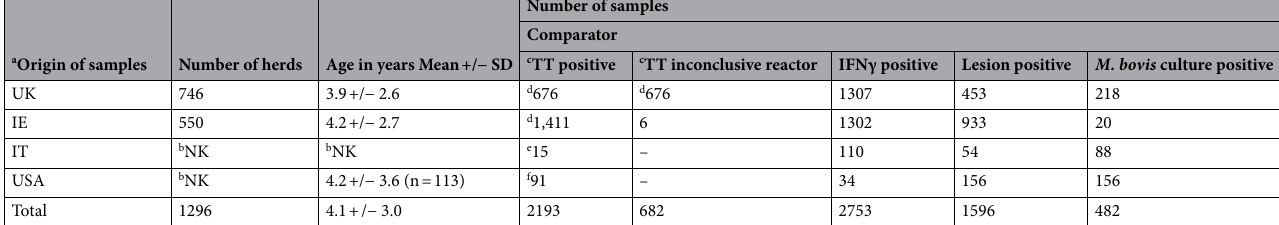
Table 2. Summary of positive field reference serum samples. a Serum samples were obtained from bTB breakdown herds in the United Kingdom (UK), Ireland (IE), Italy (IT), and United States of America (USA). The comparators used for validation were tuberculin tests, tuberculin test inconclusive reactors, IFNg test, lesions at post-mortem, and culture of M. bovis from post-mortem tissues. The total number of samples tested using the Enferplex bTB test for each comparator is shown in the last row of the Table. b NK—not known. c TT—tuberculin test. d SICCT; e SICT; f CFT.